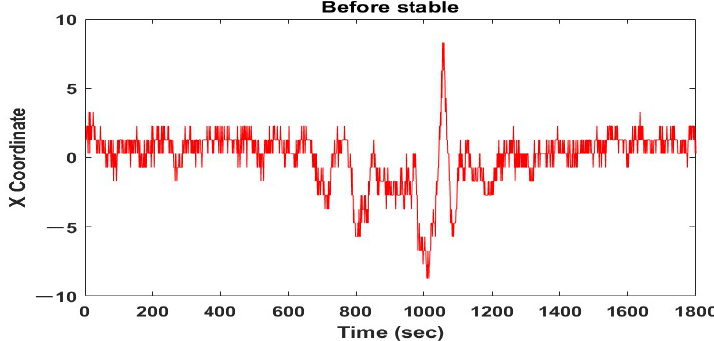
Figure 3. X coordinate position with time.